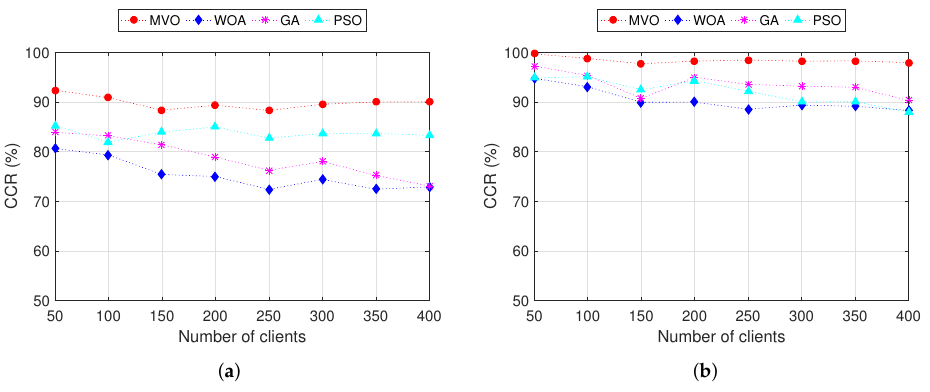
Figure 8. Performance comparison of the CCR versus the number of clients. ( a ) INS-3. ( b ) INS-4. Table 7. Performance comparison of the number of connected clients and CCR when executing INS-3 and